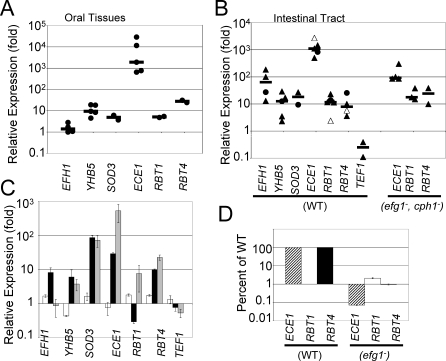
Expression of C. albicans GenesExpression of genes of interest in cDNA preparations was determined by qRT-PCR as described in Materials and Methods. Results were normalized using actin expression and are expressed relative to a reference sample of laboratory-grown log phase cells.(A) Gene expression in C. albicans cells recovered from the oral cavities or esophagi of IGB piglets. Closed circles, WT C. albicans cells (SC5314) recovered from the tongue, roof of the mouth, or esophagus; bars, geometric means.(B) Gene expression in C. albicans cells recovered from the intestinal tract. Closed circles, WT C. albicans cells (SC5314) recovered from the large intestine of an IGB piglet; closed triangles, WT (SC5314 or DAY185), or mutant (efg1 cph1 double null) C. albicans cells recovered from the cecum of Swiss Webster mice; open triangles, WT C. albicans (SC5314) recovered from the ileum of Swiss Webster mice; bars, geometric means.(C) Gene expression during laboratory growth. White bars, log phase C. albicans grown in rich medium at 37 °C; black bars, post-exponential phase C. albicans grown in rich medium at 37 °C; grey bars, hyphal C. albicans grown in RPMI-serum at 37 °C; error bars, standard deviation.(D) Comparison of gene expression in WT C. albicans (DAY185) and in an efg1 deletion mutant grown in RPMI-serum at 37 °C. Cross-hatched bars, relative ECE1 expression; white bars, relative RBT1 expression; black bars, relative RBT4 expression; error bars, standard deviation.